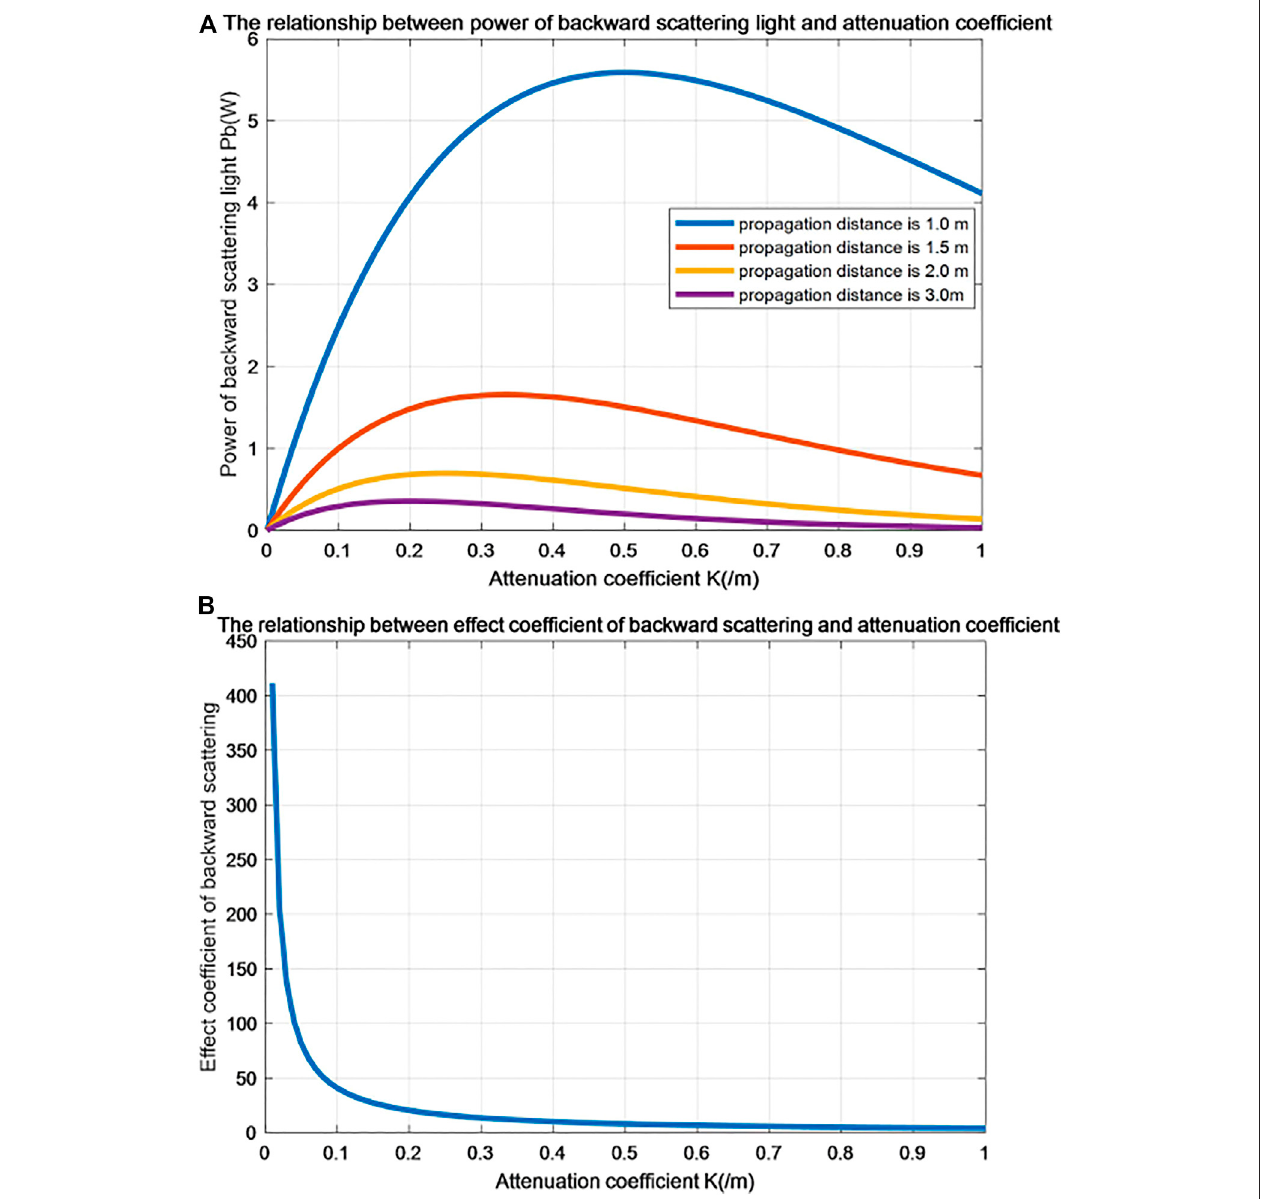
FIGURE 3 | The relationship between backward scattering and attenuation coef fi cient. (A) The relationship between power of forward scattering light and attenuation coef fi cient. (B) The relationship between effect coef fi cient of forward scarttering and attenuation coef fi cient.